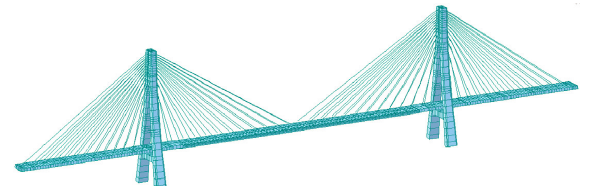
Figure 8: The finite element model of Ganjiang River Bridge.